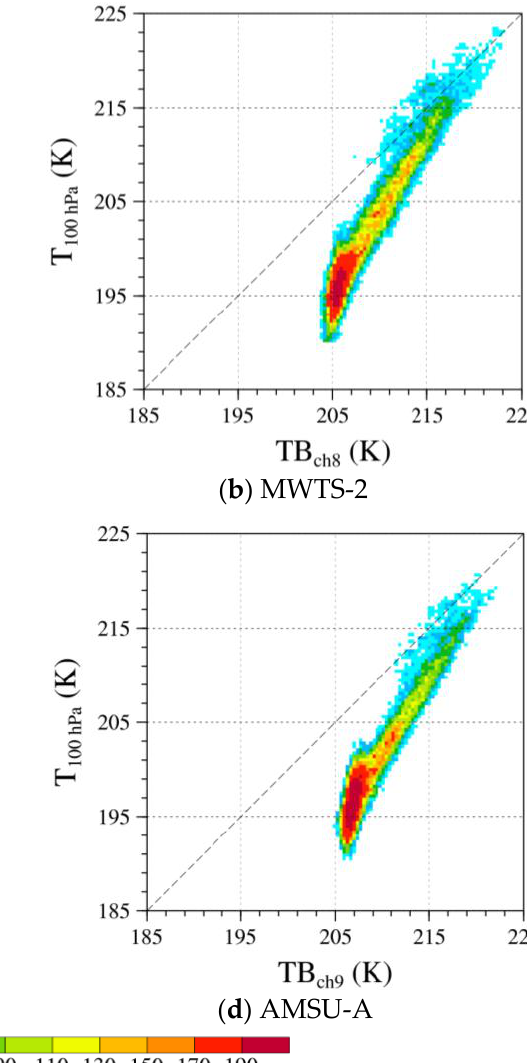
Figure 4. Spatial distributions of ( a ) FY-4A AGRI 0.65-μm reflectivity at 0600 UTC on 10 July 2019, and ( b , c ) the bias-corrected O-B (unit: K) and ( c ) clear-sky data points over ocean identified by N18 (cyan) and N20 (magenta) schemes for MWTS-2 channel 1 (50.3 GHz) at FY-3D ascending nodes on 10 July 2019. The yellow and cyan lines in ( a ) stand for the MWTS-2 limb lines in ( b ).